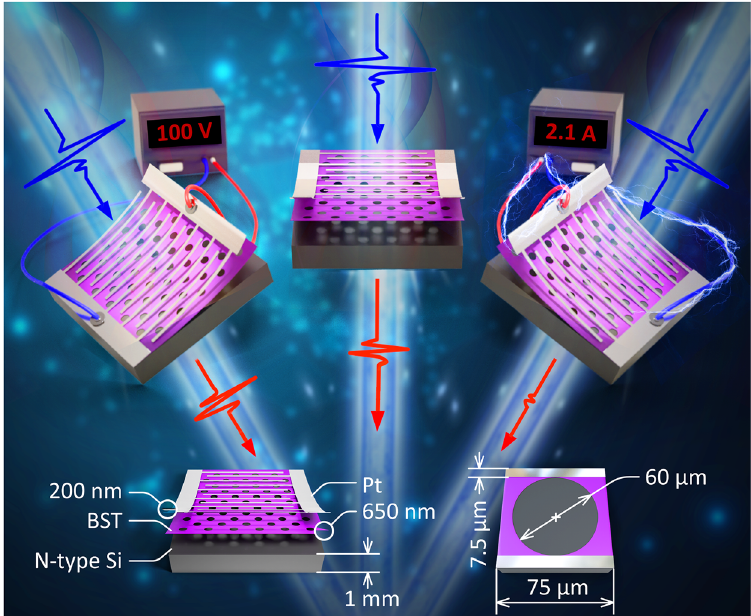
Figure1: SchematicdiagramoftheproposedBST – silicon hybrid meta-modulator for tuning trans- mittedTHzwavesunderdifferentstimulusmodes (left side for voltage tuning mode, right side for current tuning mode, and middle for compari- son). Inset: detailed parameters of the proposed